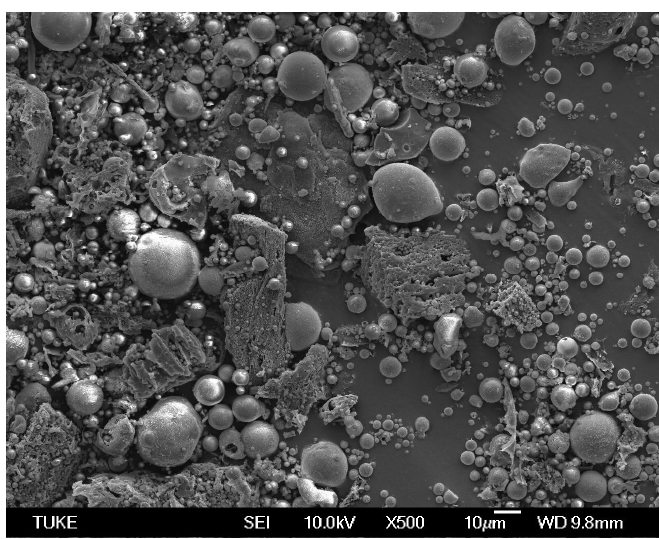
Figure 2. SEM picture of HDFA.